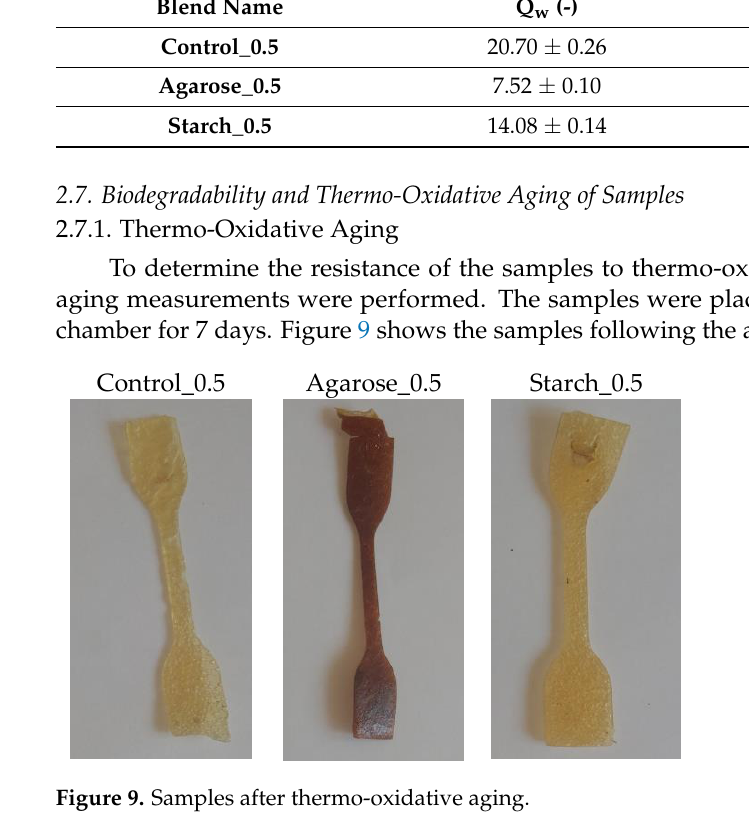
Table 4. Results of equilibrium swelling analysis (Q w ) and degree of cross-linkage ( α c ).